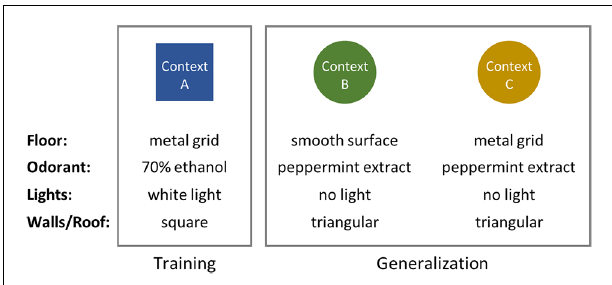
FIGURE 1 | Schematic of contexts used in fear conditioning and generalization experiments. Context B was designed to be as perceptually distinct as possible from the training context (Context A). Context C retains the metal floor grid used in Context A, but is otherwise identical to Context